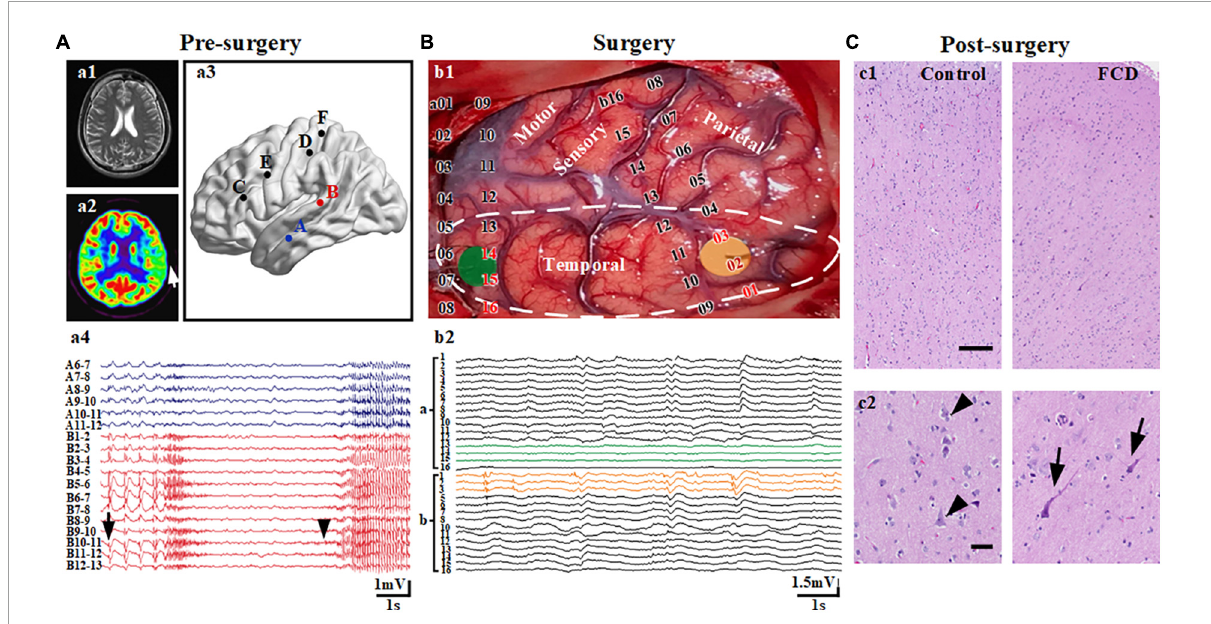
FIGURE1 Localization of the seizure onset zone (SOZ) and non-seizure onset zone (non-SOZ). (A) Presurgical evaluation and confirmation of SOZ. (a1,2) Represents an area of hypometabolism in the left middle temporal lobe (arrow) in a PET scan of the patient with focal cortical dysplasia (FCD) having a negative MRI. (a3,4) Represents spontaneous recurrent rhythmic interictal spikes (arrow) and ictal discharges (arrowhead) restricted to the region in the left middle temporal gyrus from electrode B in the stereo-electroencephalograph recordings. (B) Reconfirmation of neocortical samples during surgery. (b1) The yellow and green areas reflect the areas of tissue samples used for electrophysiological recording. (b2) Recordings based on electrocorticography (ECoG) showed continuous epileptiform discharges (yellow line) and normal background activity (green line) in the temporal region. The area surrounded by a white dotted line is the region being removed. (C) Post-surgery histological examination with FCD IIa. (c1) Hematoxylin and eosin (H and E)-stained section of brain tissues of control and FCD groups. (c2) The left section shows relative normal shaped and arranged neurons (arrowheads) in the lateral neocortex from patients with mesial temporal lobe epilepsy. The right section represents the extension of the area in the first panel showing dysmorphic neurons with disrupted cortical lamination (arrows). Scale bars represent 500 and 100 µ m for the first and second panels,